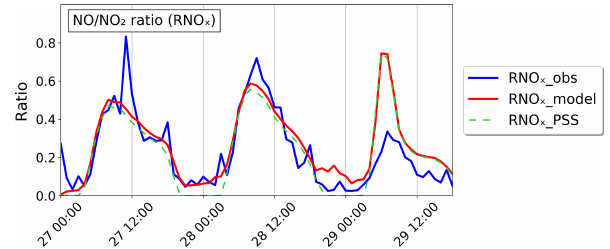
Figure 14. Observed and modeled (NO / NO 2 ) ratio (RNOx) on 27– 29 June at IRCEL-CELINE sites within the inner domain. Also shown is the ratio at photochemical steady state (RNOx_PSS), based on the concentrations and rates from the model